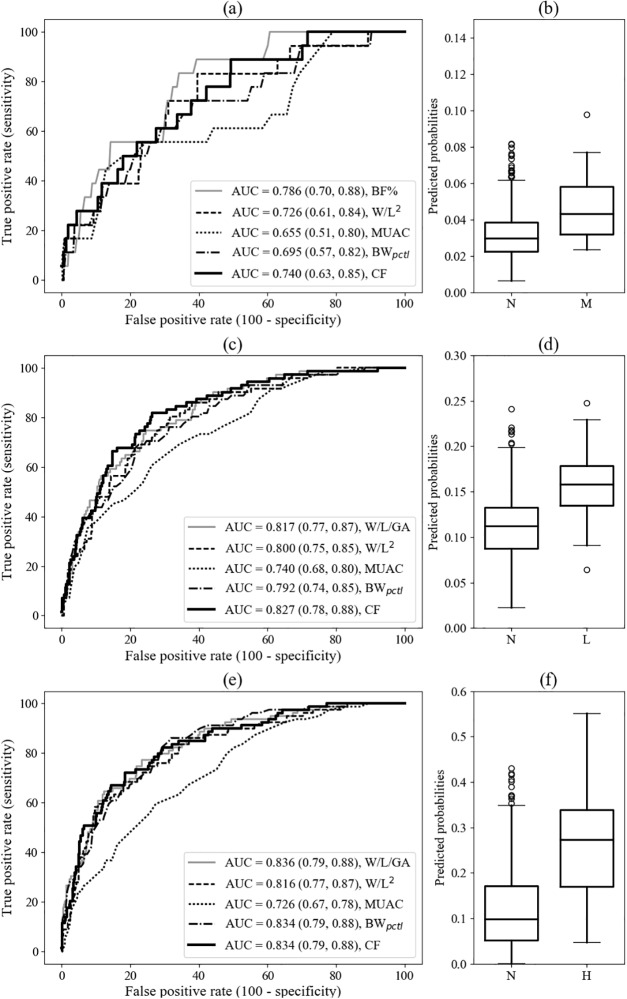
Receiver-operator characteristic curves and predicted probabilities for developed logistic regression models.Panels (a), (c) and (e) display the ROC curves for each of the developed (CF) models and other comparative models for the identification of composite neonatal morbidity [12], low BF% and high BF%, respectively. Comparative models include those fitted using body fat percentage (BF%), weight for length (W/L), mid-upper arm circumference (MUAC) and birthweight percentile (BWpctl). Corresponding boxplots in (b), (d) and (f) show the predicted probabilities from the corresponding CF logistic regression models for each of the two classes: negative (N) and positive (M: composite neonatal morbidity, L: low BF% and H: high BF%).